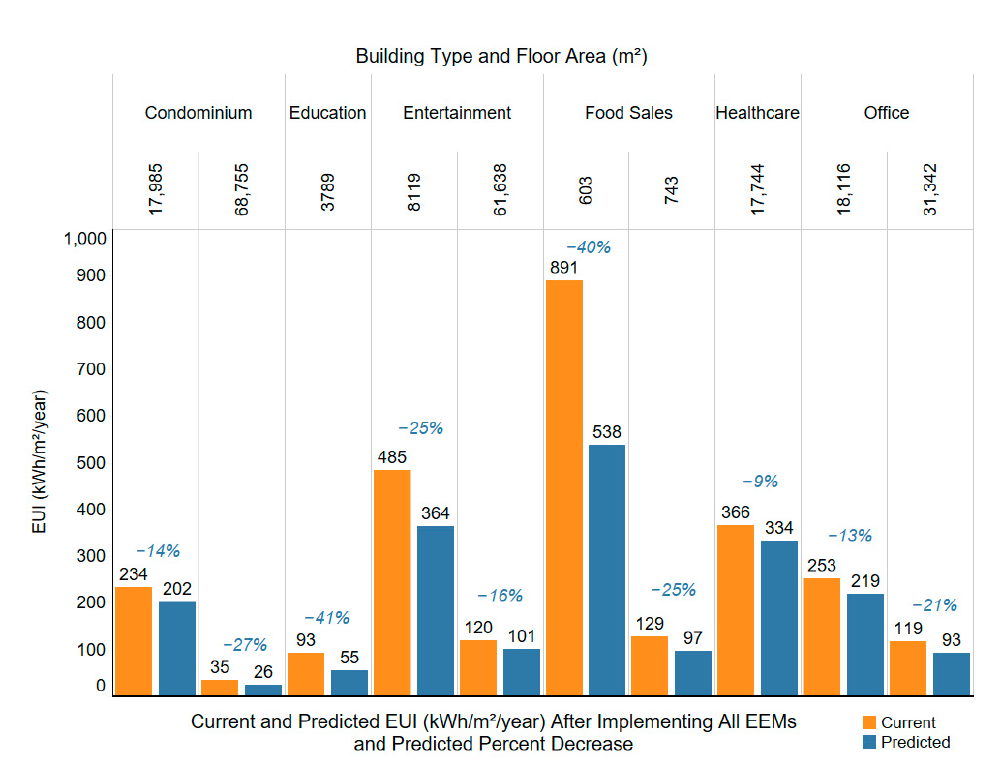
Figure 6. Current EUI and predicted EUI (kWh/m 2 /year) after implementing all EEMs suggested by the virtual energy audits, and the percent decrease in energy consumption.